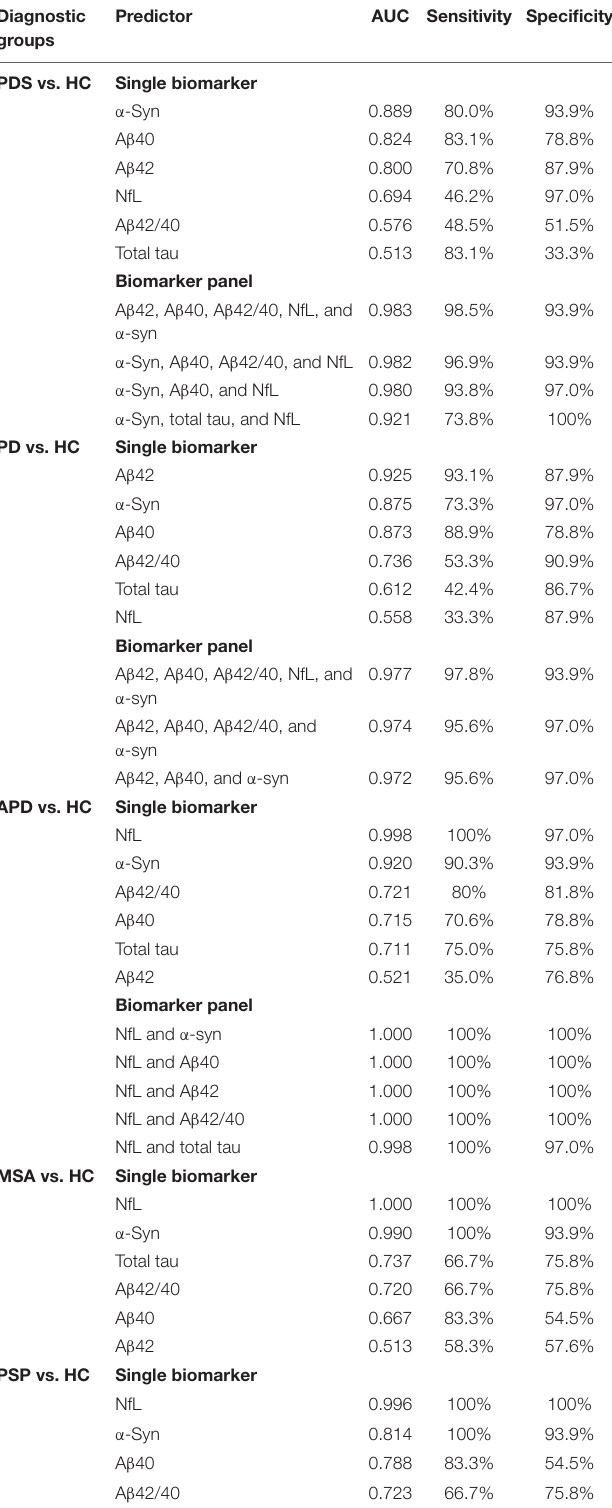
TABLE 2 | Discriminatory value of plasma NfL, total tau, A β 42, A β 40, A β 42/40 and α -syn as a single biomarker and as part of plasma biomarker panel in differentiating PDS (PD and APD) from